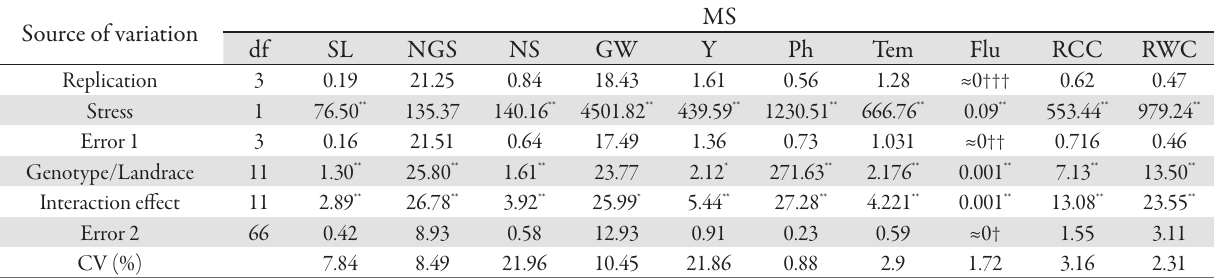
Tab. 2. Analysis of variance for agro-morphological traits in genotypes/landraces of barley grown under water deficit stress and normal conditions Source of variation